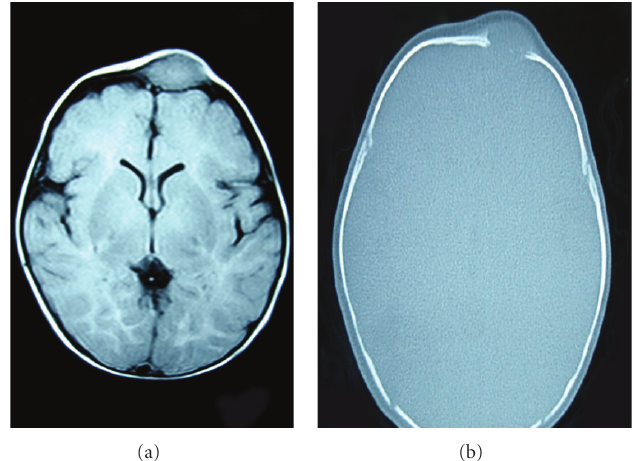
Figure 2: (a) T 2 weighted image showing a well-defined mass, mildly hyperintense in comparison to brain and (b) T 1 weighted image showing well-defined lesion with lytic cortical borders with homogenous